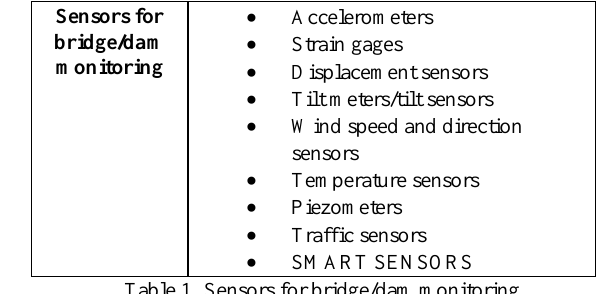
Table 1. Sensors for bridge/dam monitoring (Live et al., 2001).